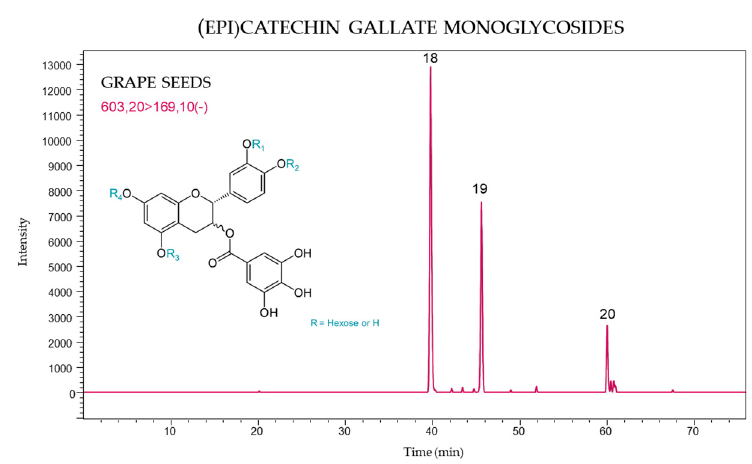
Figure 4. (Epi)catechin gallate monoglycoside profile of V. vinifera grape seeds using MRM [603 → 169].